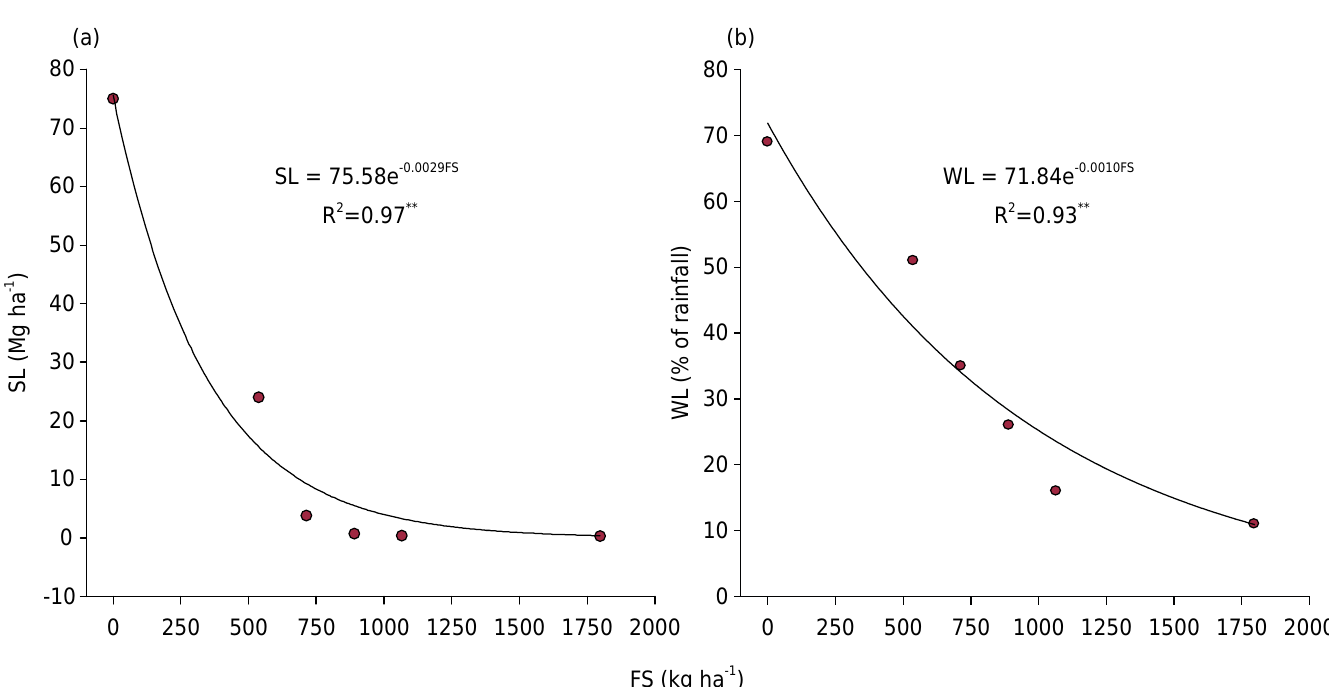
Figure 2. Relationship of (a) soil losses (SL) and (b) water losses (WL) to the fertilizers applied (FS) in the soil (triple superphosphate - TSP and potassium chloride - KCl) during the experimental period from 2003 to 2015 in the treatments studied in experiment I. **: